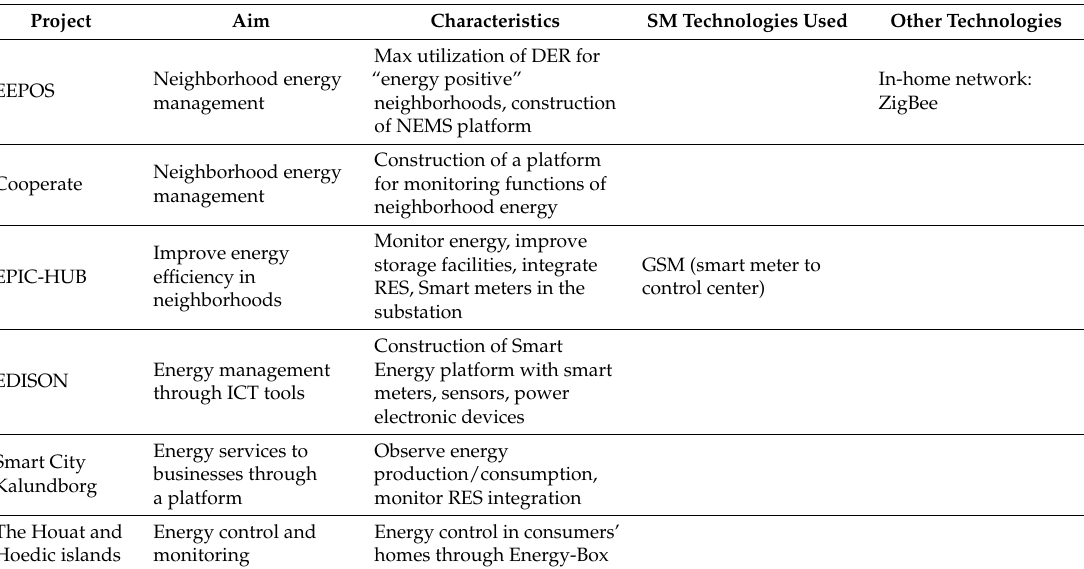
Table 6. Summary of projects for energy management through ICT